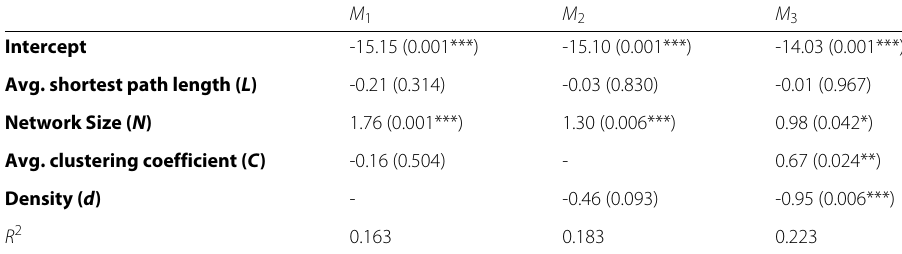
Table 2 The regression coefficients of each of the three linear models. Model M 1 is log ( y ) = ω 0 + ω 1 L + ω 2 N + ω 3 C , model M 2 is log ( y ) = ω 0 + ω 1 L + ω 2 N + ω 4 d , model M 3